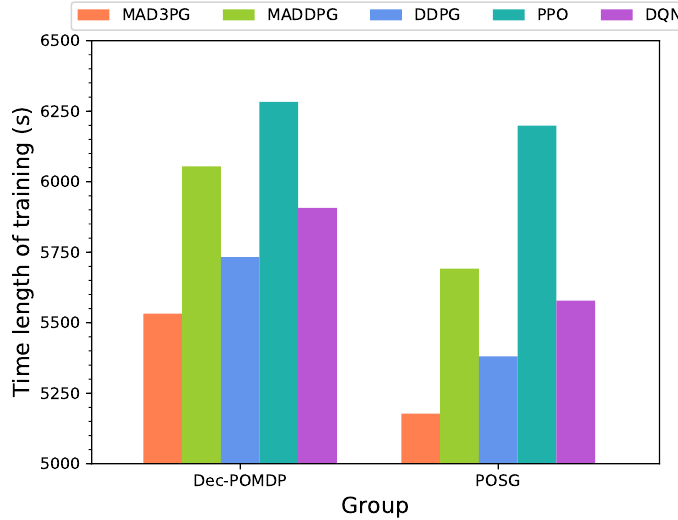
Figure 4. The training time cost during the same number of episodes.